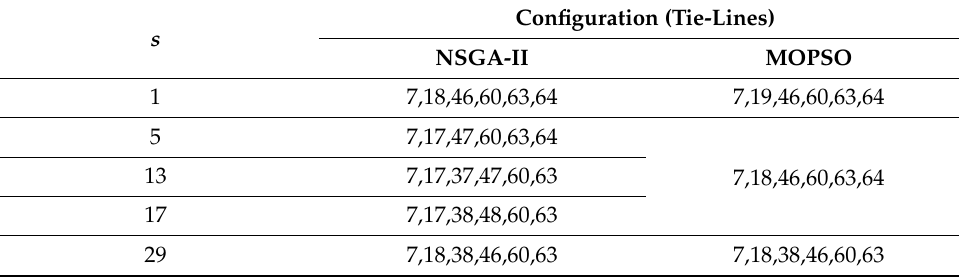
Table 9. The 59-node distribution network configurations at multiple scenarios.